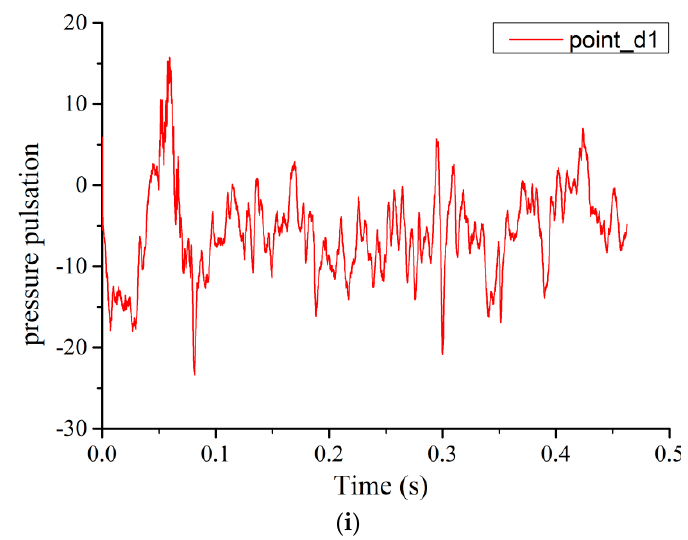
Figure 23. Static pressure fluctuation at different monitoring points.(a) at point a,(b) at point b, (c) at point c, (d) at point d, (e) at point b0, (f) at point c0,(g) at point b1,(h) at point c1,(i) at point d1.